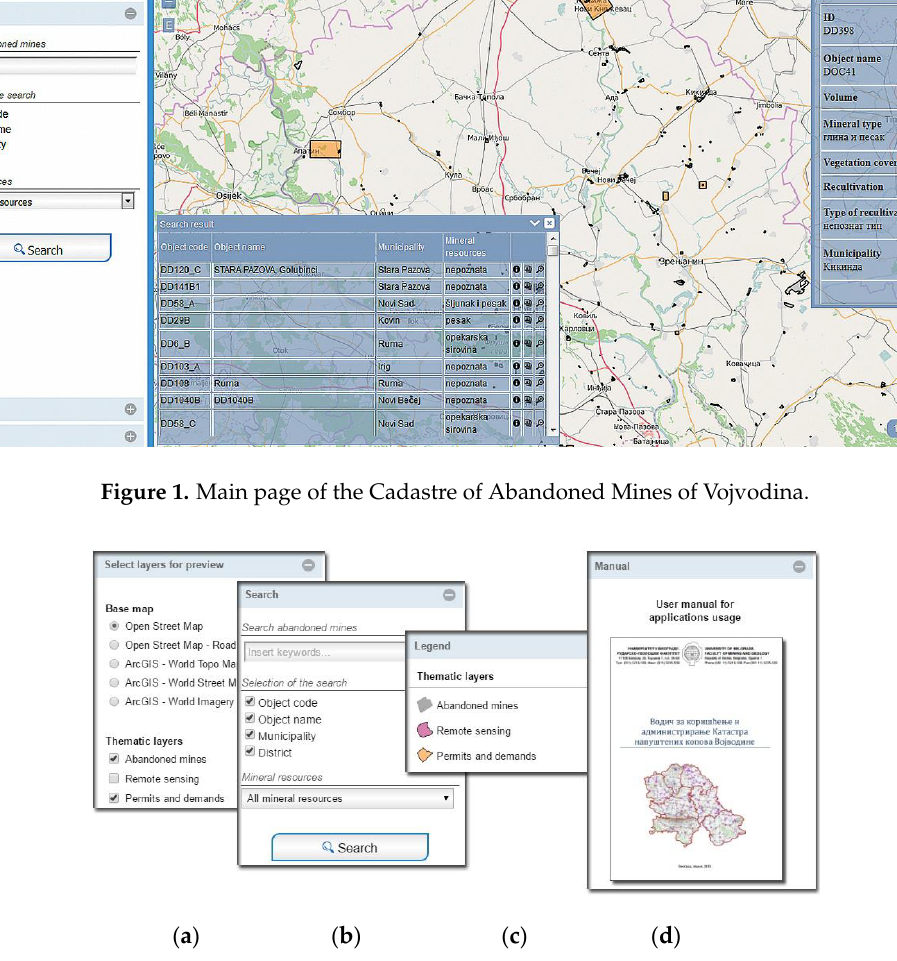
Figure 2. Selection of ( a ) visible layers; ( b ) Search; ( c ) Legend and ( d ) Manual.